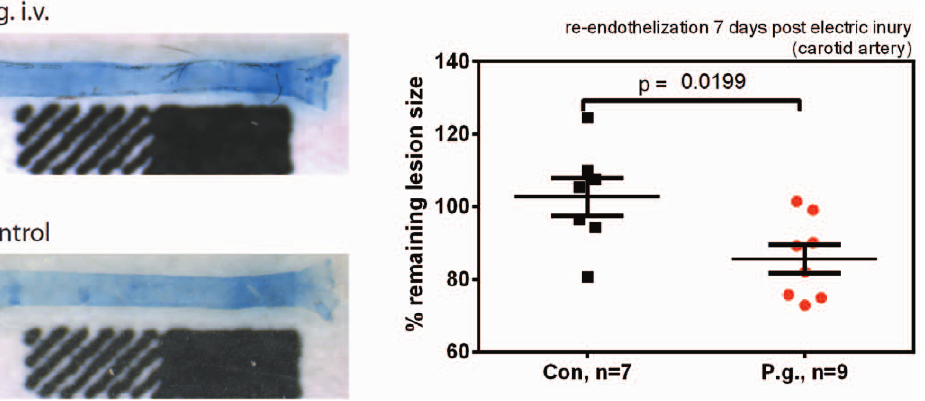
Figure 5. Improved reendothelization in P. gingivalis infected mice 5 days after electric injury of the common carotid artery. Data are expressed as proportions of non-regenerated to regenerated areas relative to saline-treated controls. Micrographs show representative results, dark blue areas mark denuded areas. Data are presented as means 6 SEM, statistical testing was performed using an unpaired t-test.